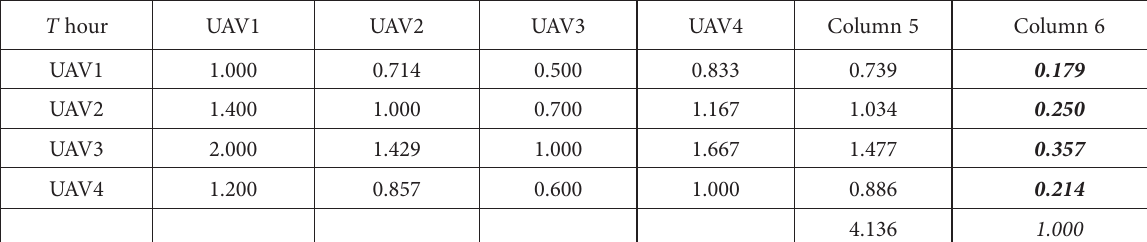
Table 7. Flight duration